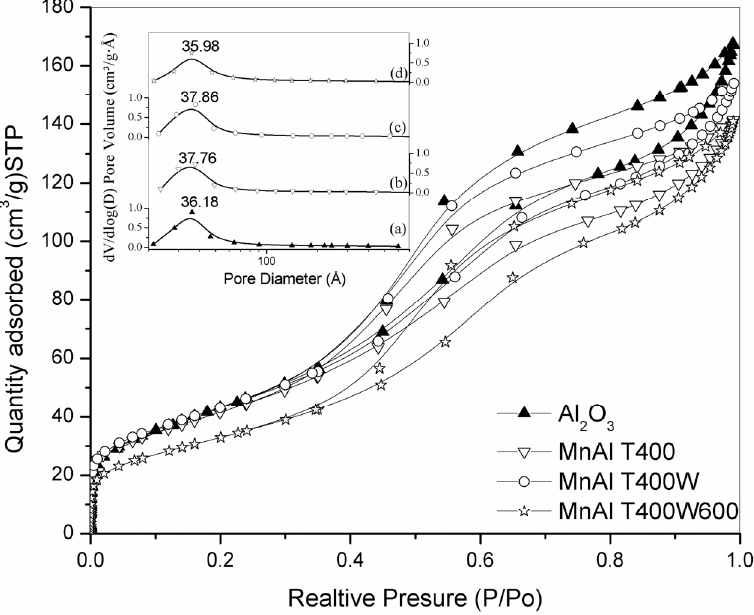
adsorption–desorption isotherms: ( a ) γ -Al Figure 6. N 2 ( d ) MnAlW600 (Inset, mesoporous size distribution obtained by BHJ